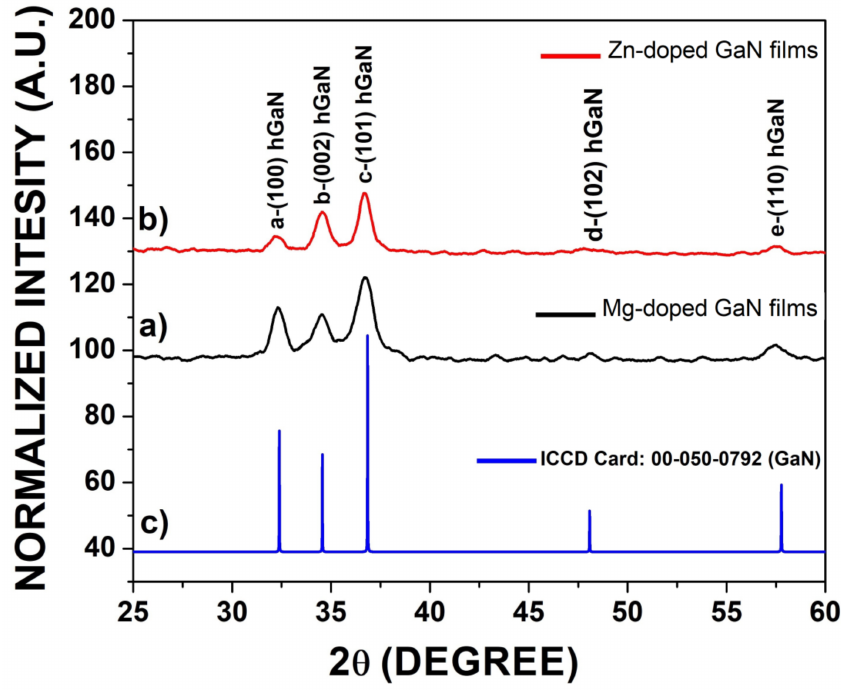
Figure 2. (a) X-ray diffraction pattern of the Mg-doped GaN films; (b) X-ray diffraction pattern of the Zn-doped GaN films; (c) ICDD card: 00-050-0792 for hexagonal